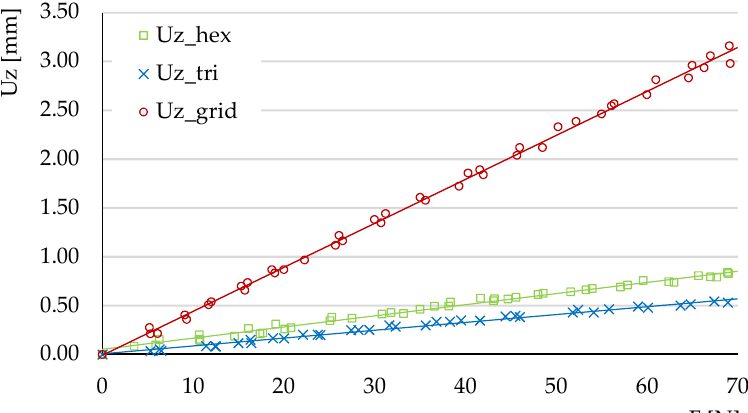
Figure 17. The comparative analysis of the variation of deflection 𝑈𝑧 = 𝑓(𝐹𝑧) for the hexagonal, triangle and grid structures, in experimental three-point bending.